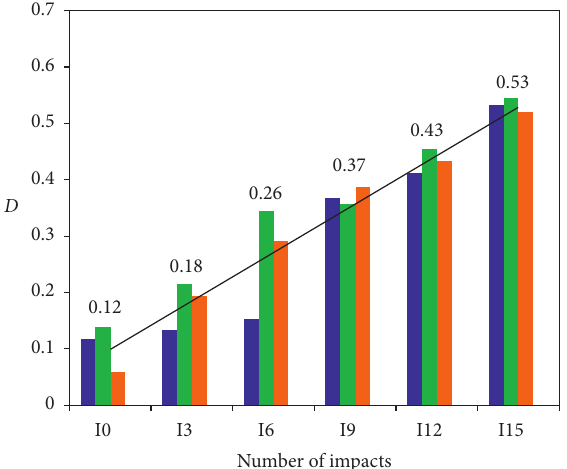
Figure 6: The calculation results of initial damage of each set of